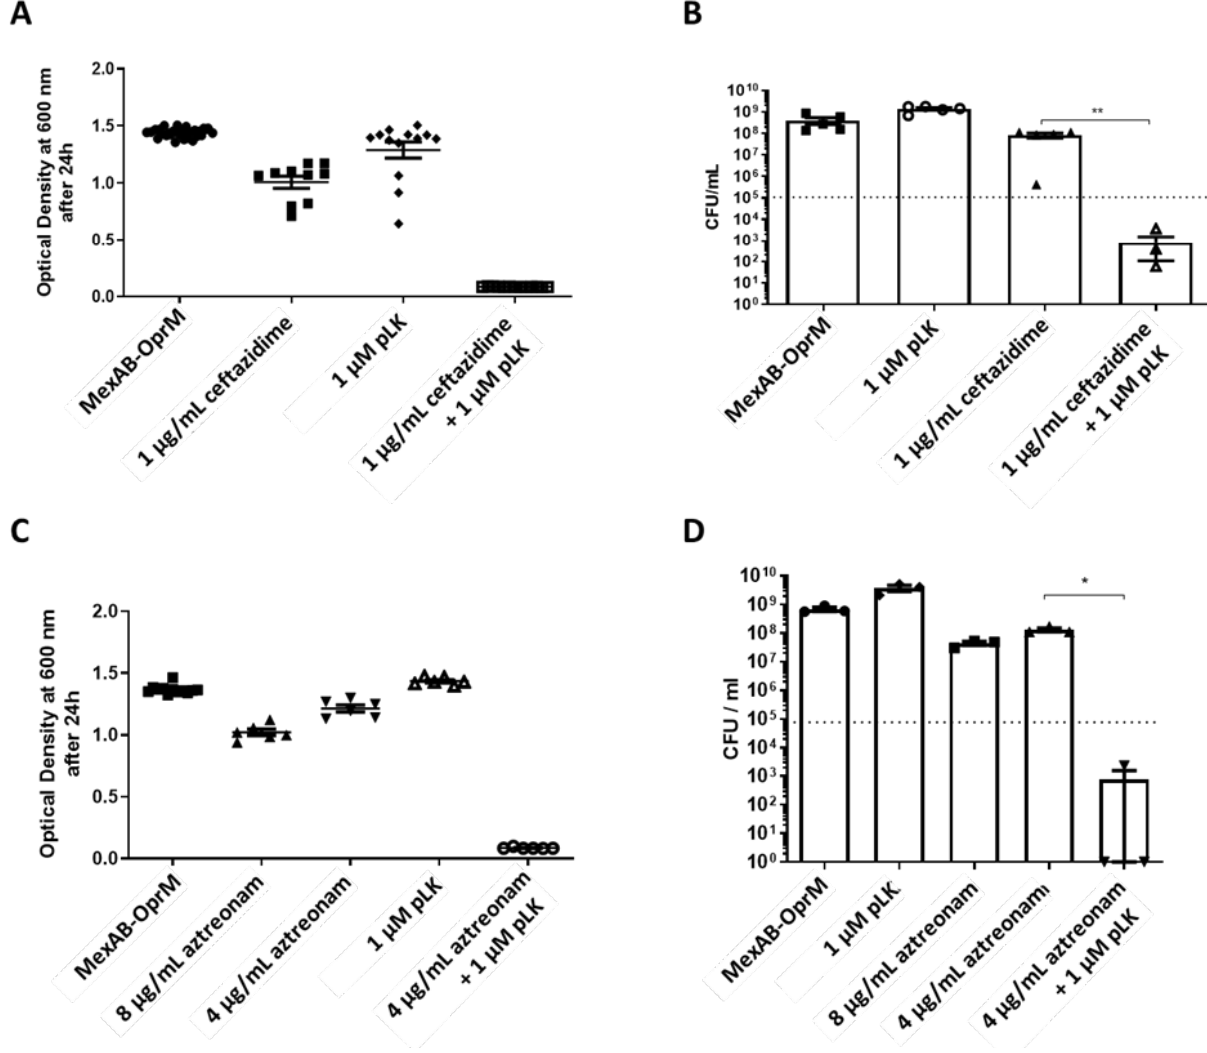
Figure 5. In vitro synergistic effect of pLK/ceftazidime or pLK/aztreonam combinations on a P. aeruginosa strain overproducing MexAB-OprM efflux pump. ( A , C ) Bacteria (1 × 10 5 /mL in exponential phase) were incubated at 37 ◦ C in Mueller–Hinton medium in the presence or absence of 1 µ M pLK, 1 µ g/mL ceftazidime, 4 or 8 µ g/mL of aztreonam, or the combination of the antibiotic with pLK. Bacterial growth was measured by monitoring the optical density at 600 nm after 24 h of incubation. ( B , D ) Determination of the colony forming unit (CFU)/mL was evaluated after 24 h of incubation. Values are mean ± SEM of five independent experiments. Statistical analysis was performed using the Mann–Whitney test (* p < 0.05, ** p <